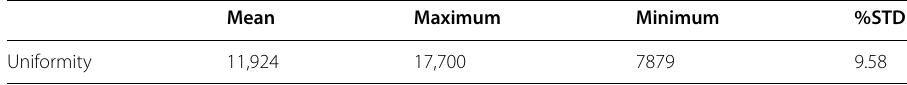
Table 4 Report for uniformity test